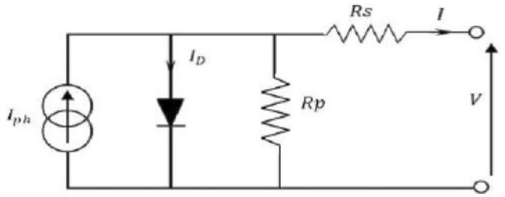
Fig. 4 Single diode model of PV